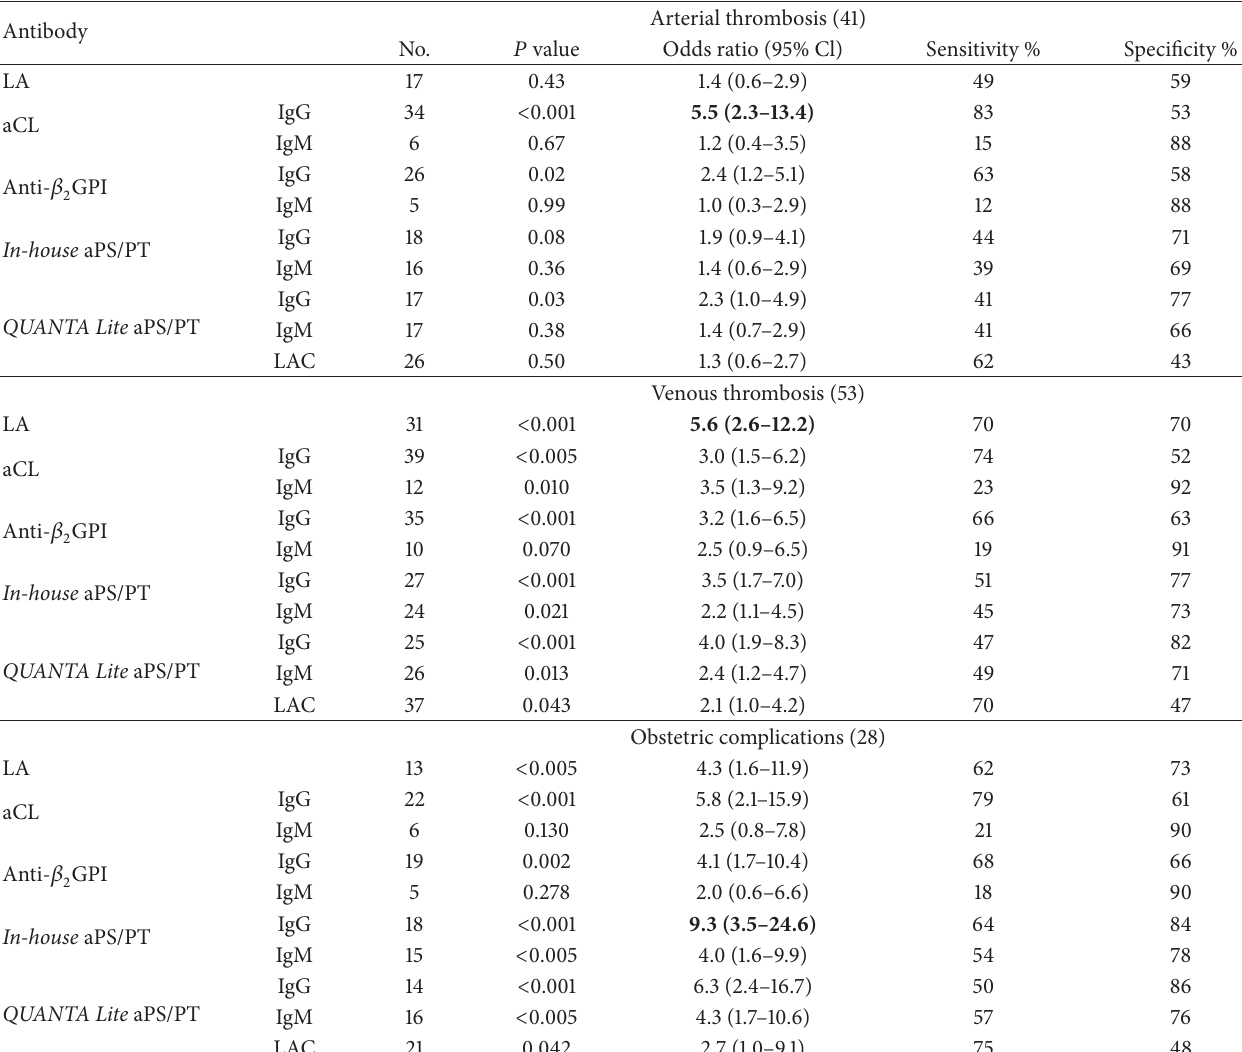
Table 2: Antiphospholipid antibodies and LA in a relationship to arterial thrombosis (AT), venous thrombosis (VT), and obstetric complications